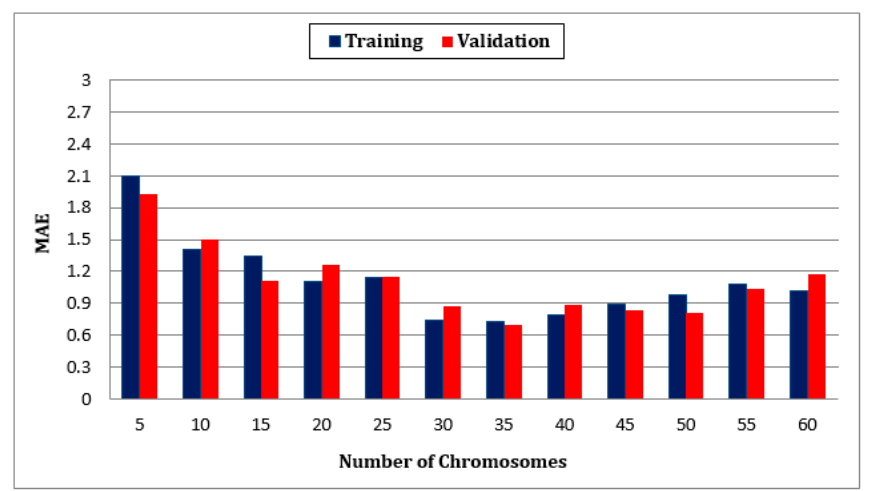
Figure 11. Comparison between mean absolute error ( MAE ) of training and validation for different numbers of chromosomes.